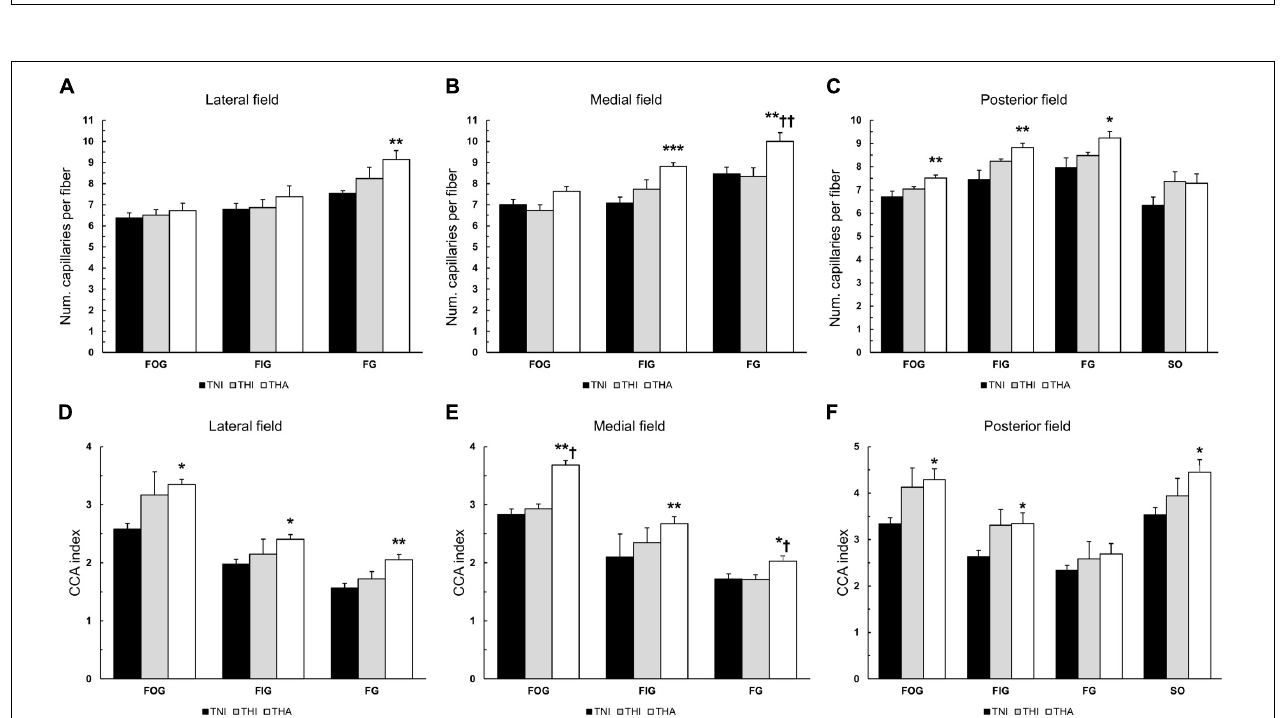
FIGURE 5 | Effects of intermittent hypobaric hypoxia (IHH) alone or in combination with light aerobic exercise on the NCF (A–C) and fiber capillarisation index (CCA) (D–F) in three TA muscle regions from trained rats. ∗ , ∗∗ , and ∗∗∗ indicate P < 0.05, P < 0.01 and P < 0.001, respectively, compared to TNI rats. † and †† indicate P < 0.05 and P < 0.01, respectively, compared to THI animals. TNI , trained normobaric inactive; THI , trained hypobaric inactive; THA , trained hypobaric active.